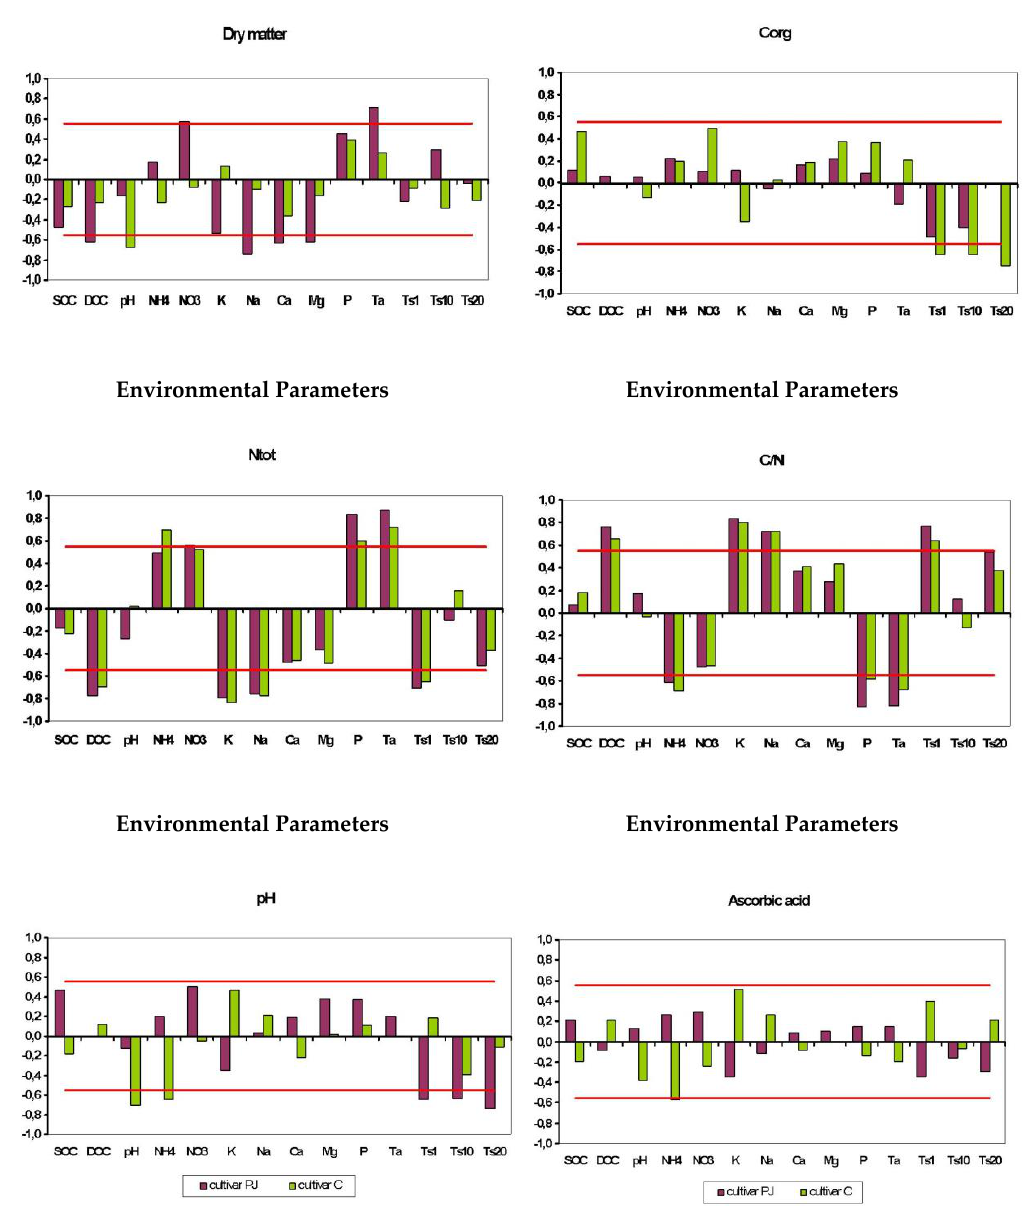
Figure 4. The correlation coefficients between Plum Jam (PJ) and Confectioner (C) husk tomato fruit characteristics, soil chemical properties, and soil and air temperature. Red lines indicate the values of correlation coefficients, above (or below) which correlation coefficients are statistically significant ( P ≤ 0.05). Environmental Parameter abbreviations: SOC, soil organic carbon; DOC, dissolved organic carbon; NH 4 and NO 3 , exchangeable soil ammonium and nitrate, respectively; Ta, the sum of air temperature over the growing season; Ts1, Ts10, and Ts20, the sum of soil temperatures at a depth of 1, 10, and 20 cm over the growing season, respectively.